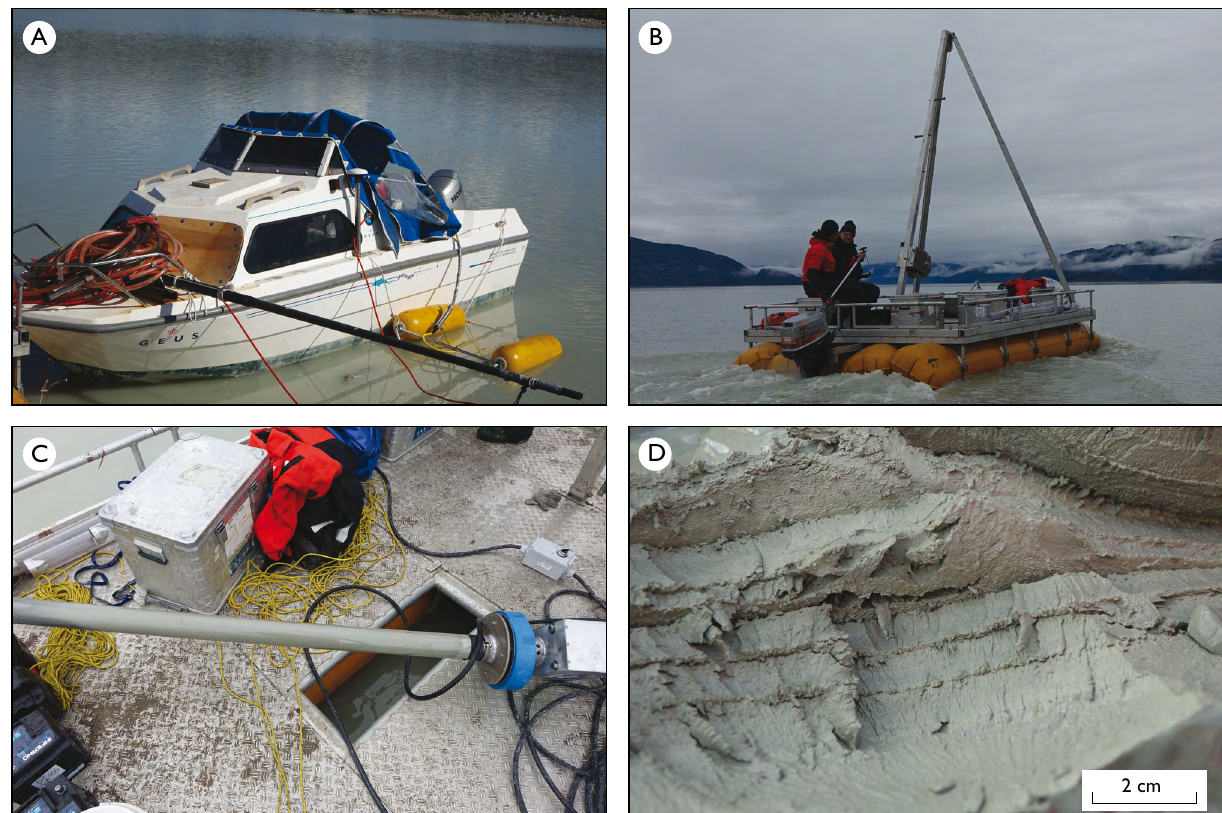
Fig. 2. Photographs from the field work. A : The GEUS II speedboat with the streamer on the foremost part of the boat and the two C-boom floats in the water. B : Deploying the coring platform on Lake Tasersuaq. C : The vibrocore with a grey sediment core in the tube, on the deck of the coring platform. D : Layered, probably varved, silt and clay sediments retrieved from the lake